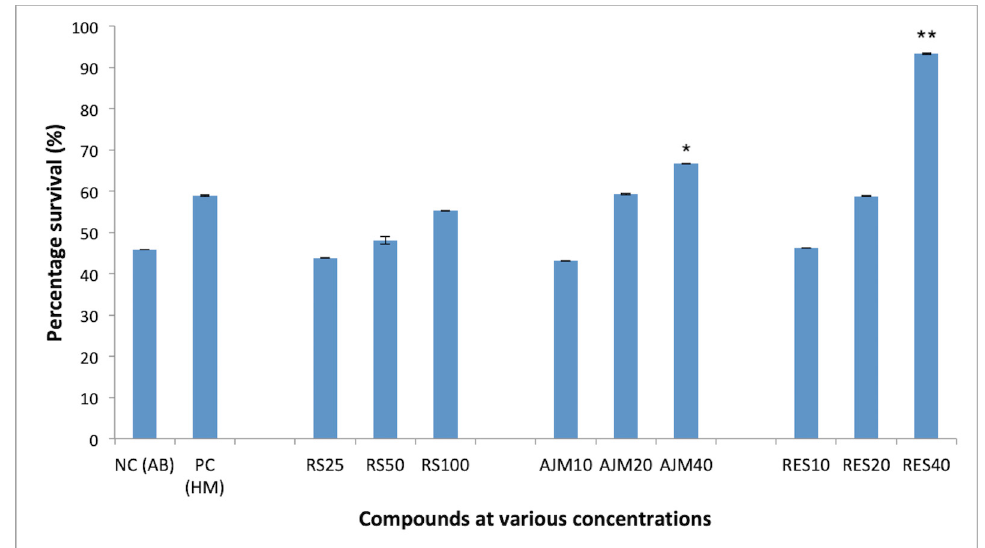
Figure 9. Concentration dependent percentage survival by MTT assay of A β 42 fibrils (48 hrs) induced neurotoxicity on PC12 cells; RS— R.serpentina extract (100, 50, 25 μ g/mL); AJM—Ajmalicine (40, 20, 10 μ M); RES—Reserpine (40, 20, 10 μ M); NC—PC12 cells treated with A β 42 only (40 μ M); PC— Homotaurine (40 μ M), data represented as mean ± SEM, n = 3; and difference in mean is statistically significant (*) p < 0.05 and very significant (**) p < 0.01 as compared to control group.